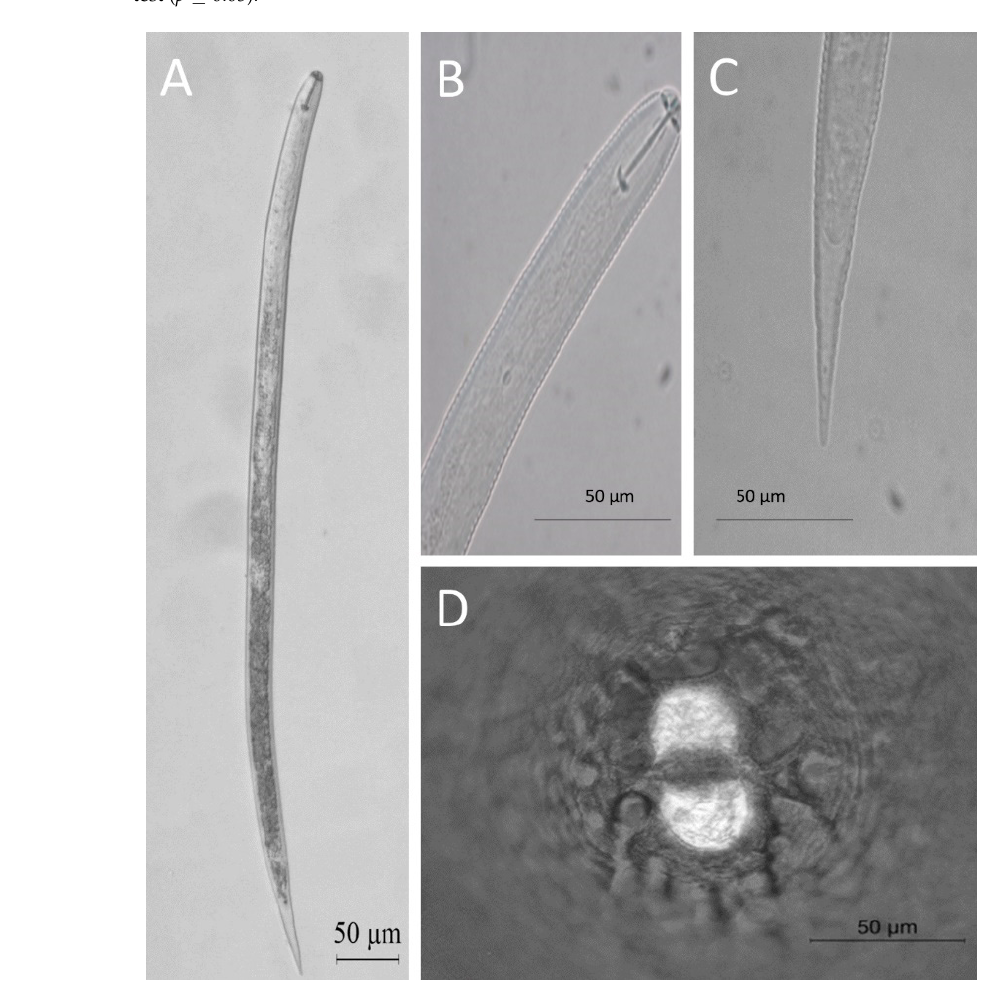
Figure 2. Heterodera filipjevi image under light microscope: ( A ) second stage juveniles; ( B ) head re- gion; ( C ) tail region; ( D ) fenestral region. ( C ) tail region; ( D ) fenestral